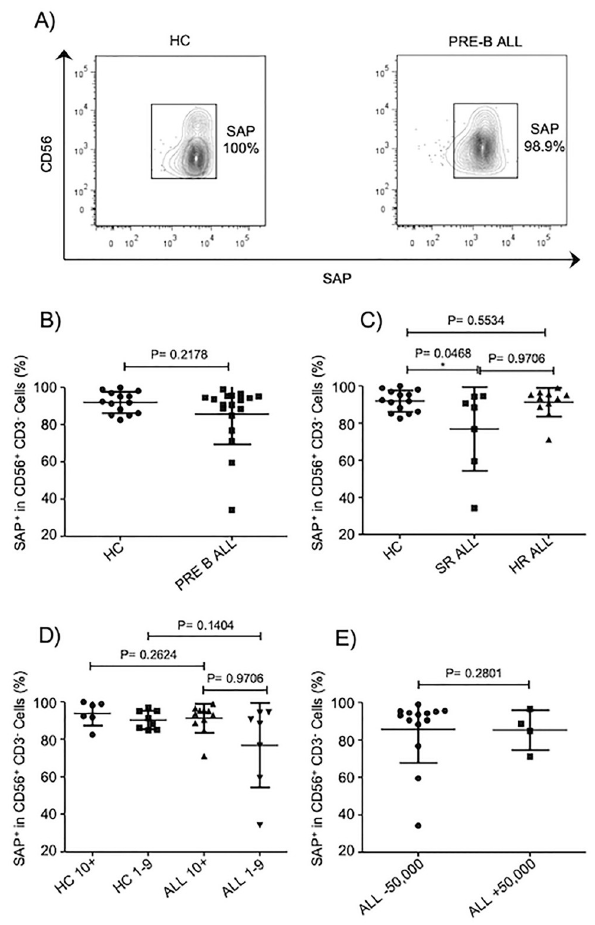
Fig 3. Frequencies of NK cells expressing SAP are normal in patients with B-ALL. A) Representative FACS plots depict frequencies of SAP+ NK cells. B) Frequencies of CD3 - CD56 + cells expressing SAP were analyzed in 18 pre- B-ALL patients compared to 14 age-matched controls. C) Frequencies of CD3-CD56+ cells expressing SAP were analyzed according to risk factor in 18 pre-B-ALL patients and 14 age-matched controls. D) Frequencies of CD3 - CD56 + cells expressing SAP were analyzed according to age in 18 pre-B-ALL patients and 14 age-matched controls. E) Frequencies of CD3 - CD56 + cells expressing SAP were analyzed according to WBC in 18 pre-B-ALL patients and 14 age-matched controls. Error bars denote standard error of the mean between individuals within group. P values report significance according to U-Mann Whitney Test one-tail.